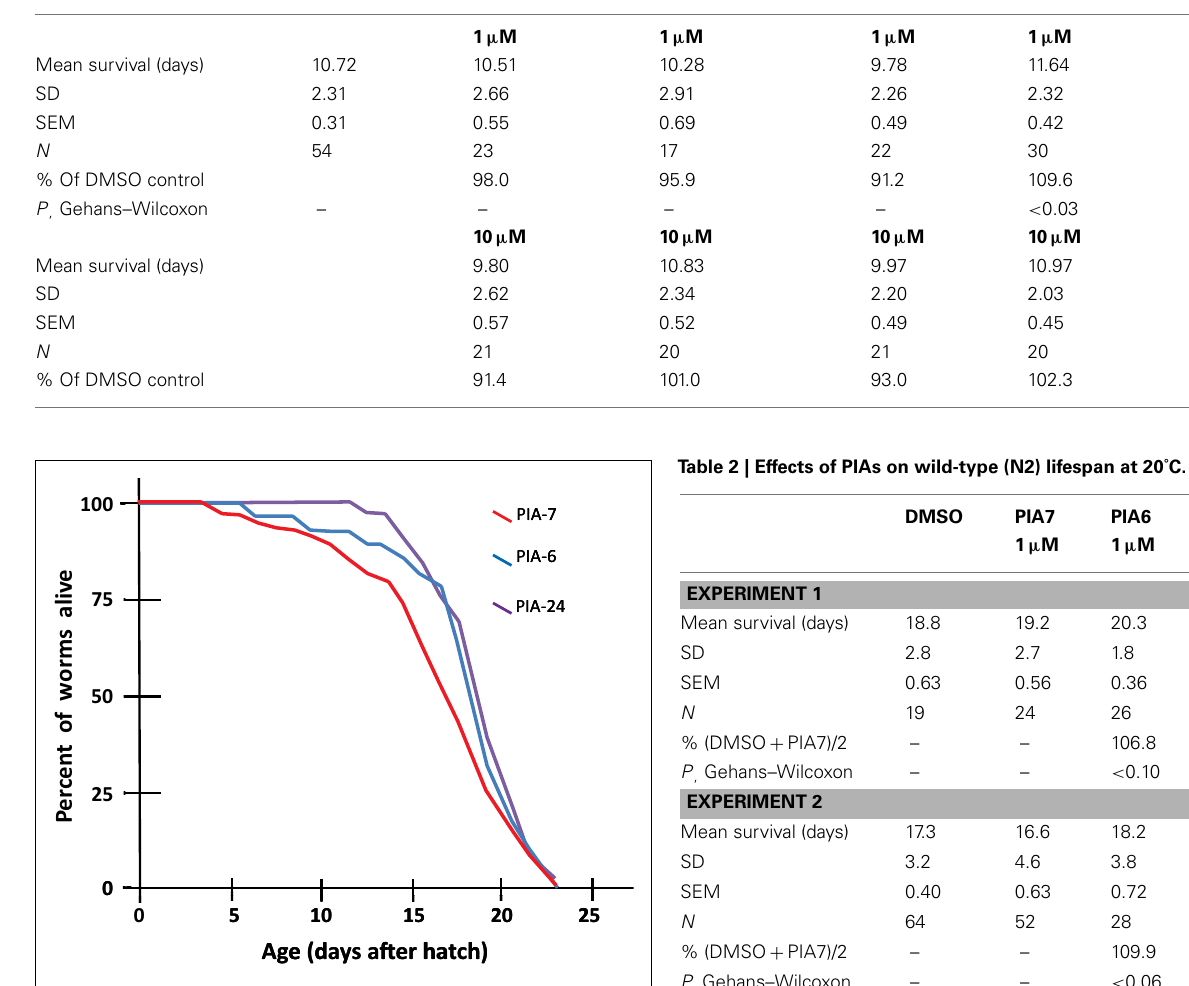
FIGURE 5 | Longevity survivals of wild-type (N2DRM) C. elegans maintained at 20˚C on plates with phosphatidylinositol analogs (PIAs).